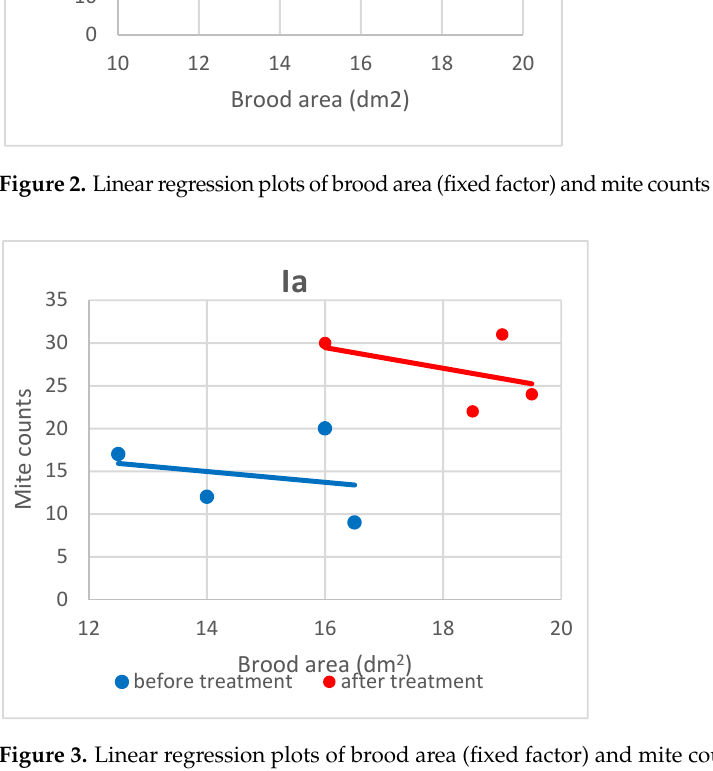
Figure 3. Linear regression plots of brood area (fixed factor) and mite counts in subgroups Ia before and after treatment.